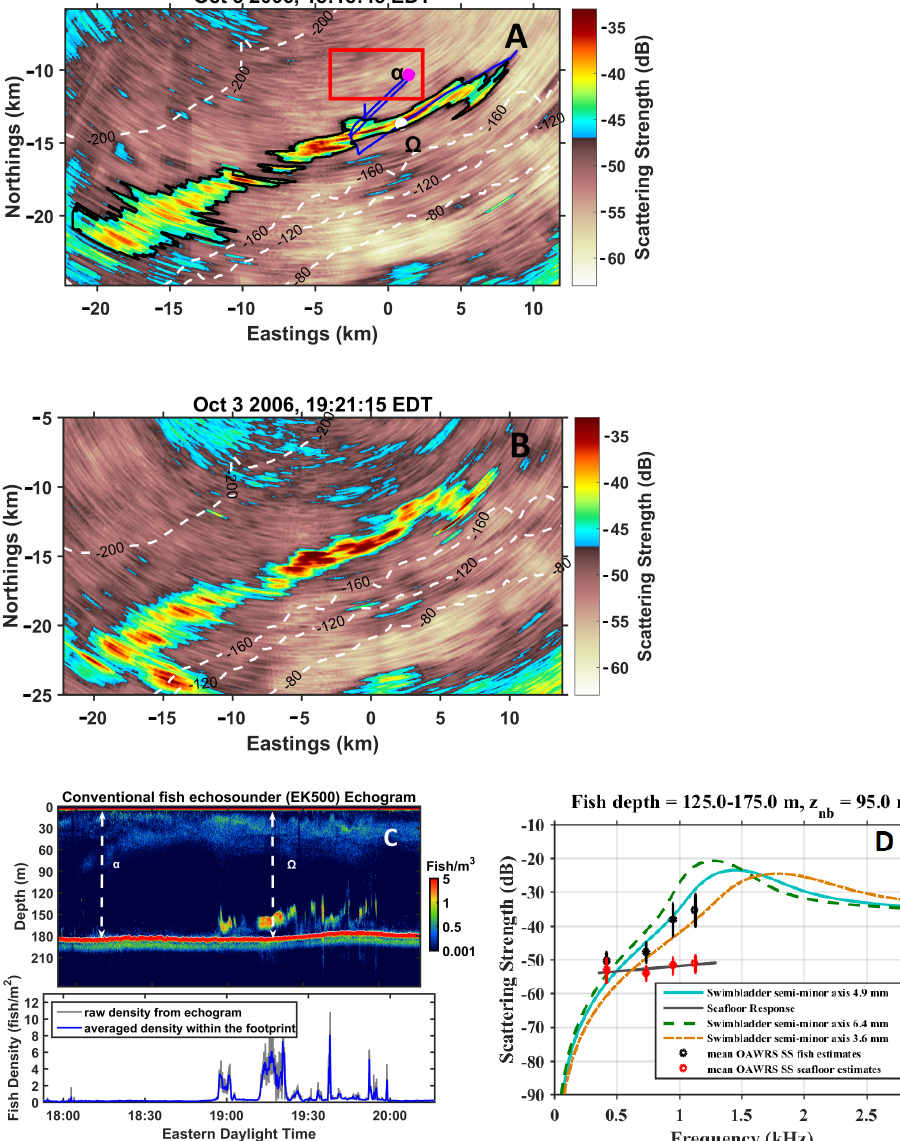
Figure 3. Discrimination of fish from seafloor scattering regions by Neyman–Pearson hypothesis testing. ( A ) OAWRS 950 Hz scattering strength measured on 3 October, at 18:18:45 EDT, with bathymetric contours (dashed white lines) dominated by scattering from massive fish shoal extending for roughly 30 km (training data within black contour) and seafloor geology (training data within red contour). Coordinate origin is located at the source array location. Data from these respective contoured regions are used to determine the likelihood functions. ( B ) OAWRS 950 Hz scattering strength image containing fish and seafloor scattering at various pixels measured on 3 October, at 19:21:15 EDT to be sorted as test data using Neyman–Pearson decision rule. ( C ) Time-depth profile of fish volumetric density (fish/m 3 ) measured by high-frequency downward-directed echo-sounding, along the blue line-transect of NOAA FRV Delaware II research vessel through the shoal shown in ( A ). White dashed vertical lines correspond to Delaware II transect start α and end Ω points. ( D ) Measured scattering strength ( SS ) versus frequency for four OAWRS center frequencies for black-bounded region in ( A ) shows excellent least-square fit with Love-model frequency response for herring with swimbladder semi-minor mean of 4.9 mm, with standard deviation typically within + / − 30% of semi-minor axis mean. Scattering strength versus frequency of red-bounded region in ( A ) show excellent correspondence with seafloor scattering